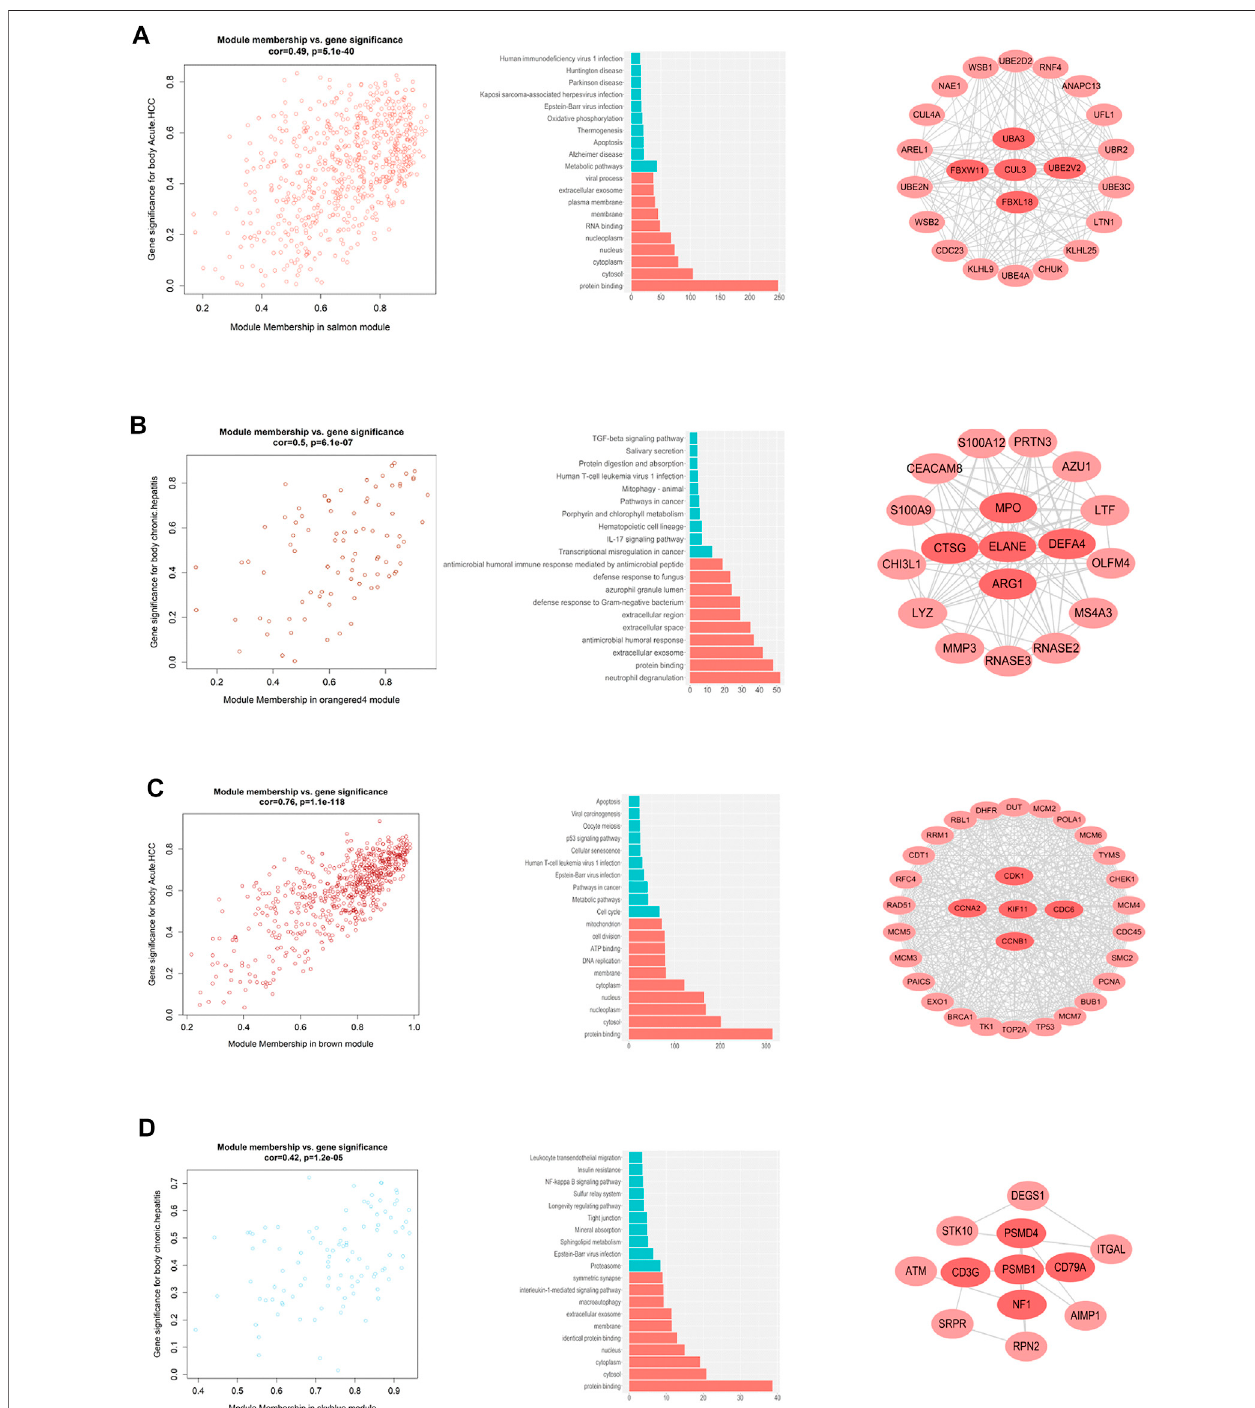
FIGURE 2 | Co-expressed gene modules that interact with other genes in different stages of HIV infection. (A) Distribution of genes in the salmon module, GO and KEGG pathway enrichment, and key genes in the early HIV infection stage of CD4 + T cells. (B) Distribution of genes in the orange4 module, GO and KEGG pathway enrichment,andkeygenesofCD4 + TcellsinthechronicHIVinfectionstage. (C) Distributionofgenesinthebrownmodule,GOandKEGGpathwayenrichment,andkey genes in the early HIV infection of CD8 + T cells. (D) Distribution of genes in the sky blue module, GO and KEGG pathway enrichment, and key genes in the chronic HIV infection of CD8 + T